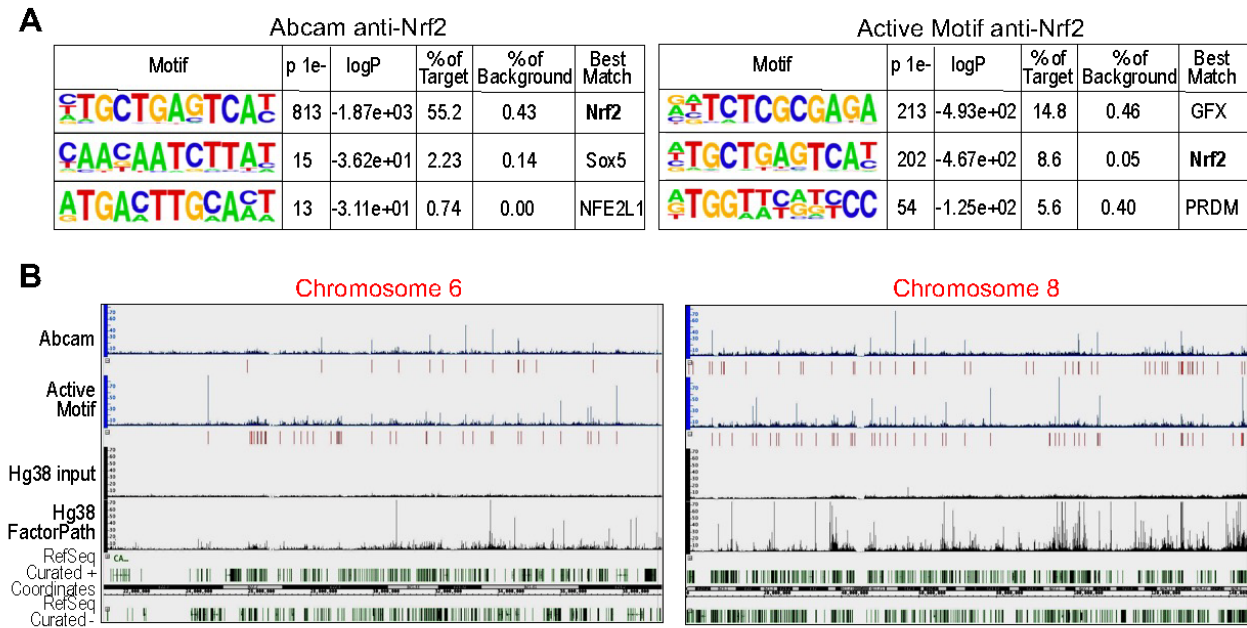
Figure 9. Two anti-Nrf2 antibodies showed different specificity and coverage in ChIP-seq. ( A ) HOMER analysis of the enriched motifs of the ChIP-seq peaks produced by the use of these two different antibodies. ( B ) Limited overlap of the ChIP-seq peaks between the indicated two antibod- ies in